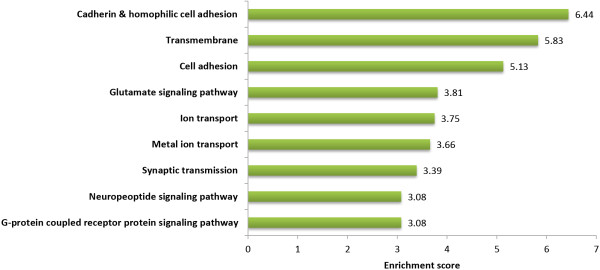
Gene functional classification of SUP enriched genes. Nine DAVID gene functional classifications with an enrichment score >3 were selected. The representative terms associated with each cluster were selected manually.